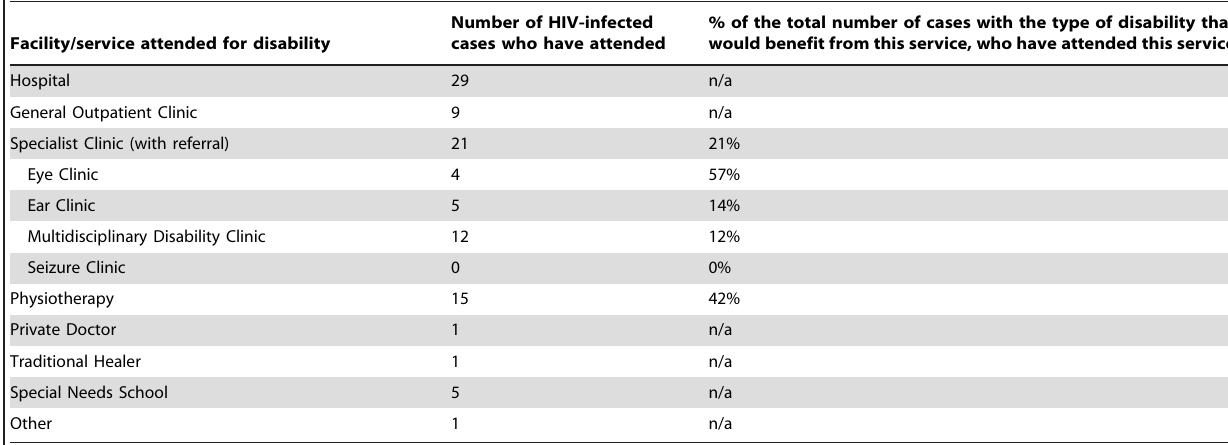
Table 6. Met and unmet rehabilitation needs for HIV-infected children with disabilities.